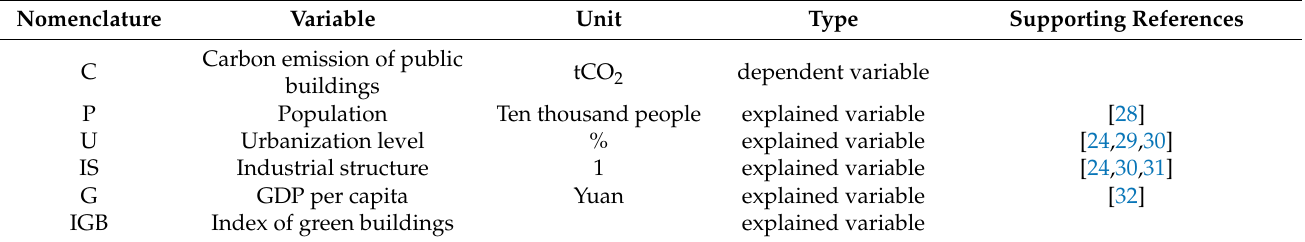
Table 2. Declaration of the model variables.